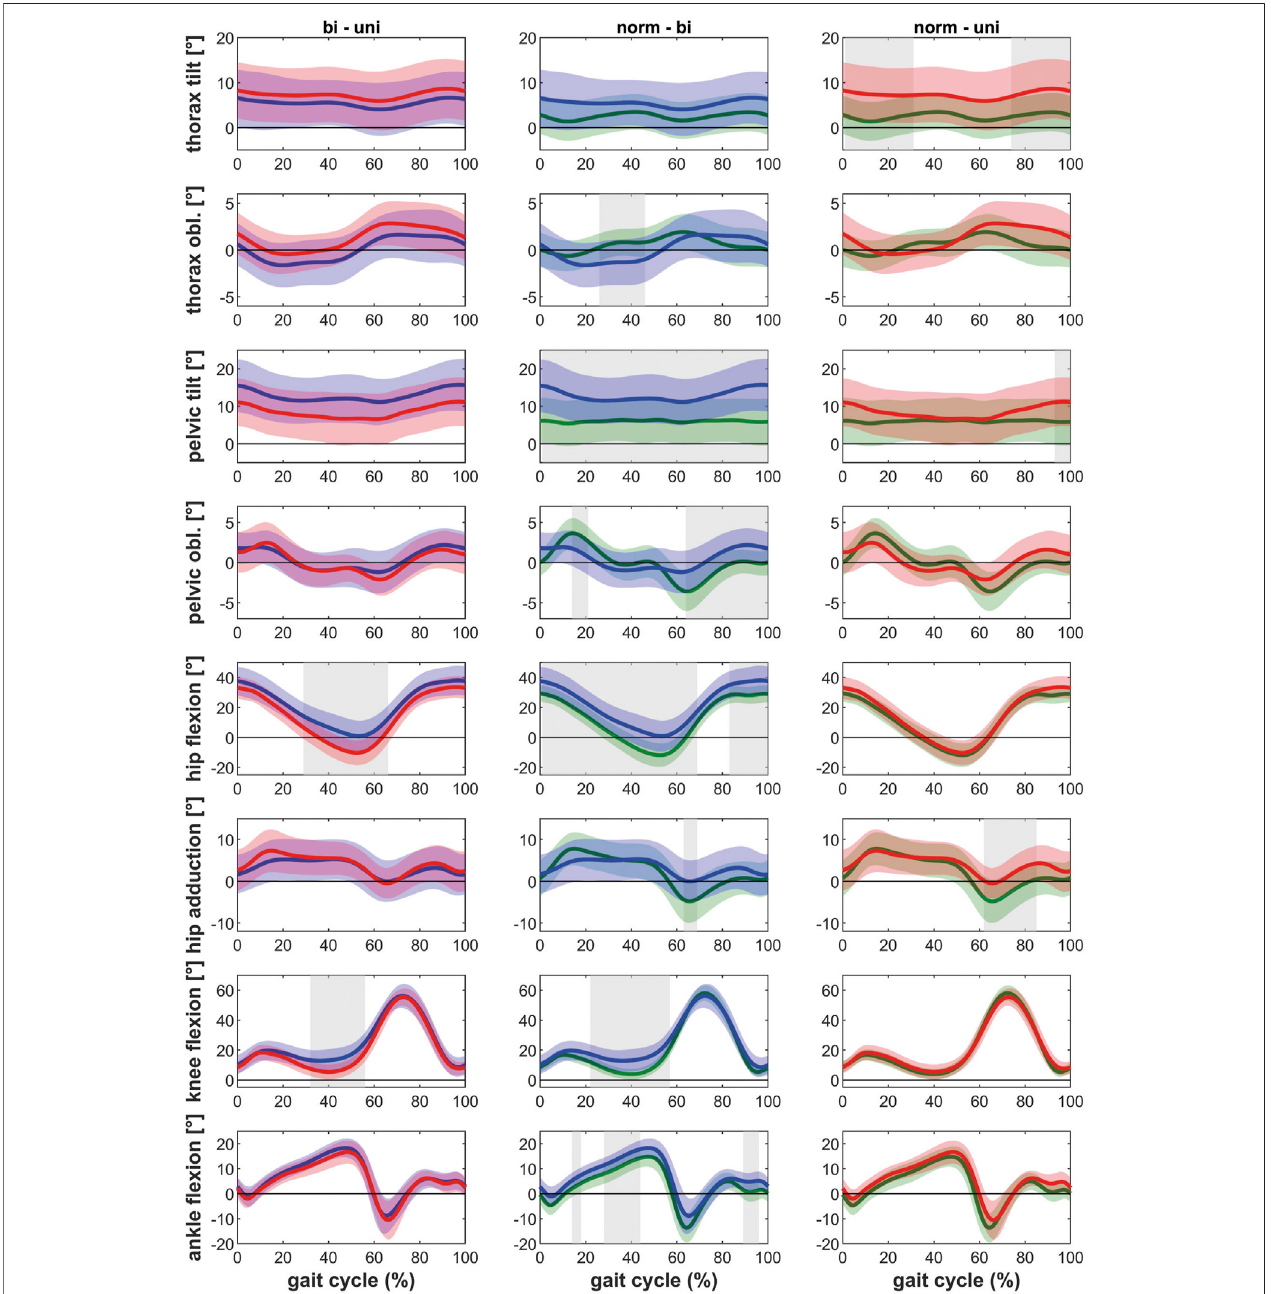
FIGURE 2 | Comparison of the kinematics of the contralateral leg between bilateral hip OA patients, unilateral hip OA patients and healthy controls. Mean and one standard deviation of the joint angles. Shaded areas indicate statistical differences. Blue lines (cid:1) bilateral patients, red lines (cid:1) unilateral patients, green lines (cid:1) healthy controls. (A – C) thorax tilt: anterior (+)/posterior ( − ); (D – F) thorax obliquity: towards the contralateral side (+)/towards the ipsilateral side ( − ); (G – I) pelvic tilt: anterior (+)/posterior ( − ); (J – L) pelvic obliquity: up (+)/down ( − ); (M – O) hip fl exion/extension: fl exion (+)/extension ( − ); (P – R) hip adduction/abduction: adduction (+)/abduction ( − ); (S – U) knee fl exion/extension: fl exion (+)/extension ( − ); (V – X) ankle dorsi fl exion/plantar fl exion: dorsi fl exion (+)/plantar fl exion ( − ).